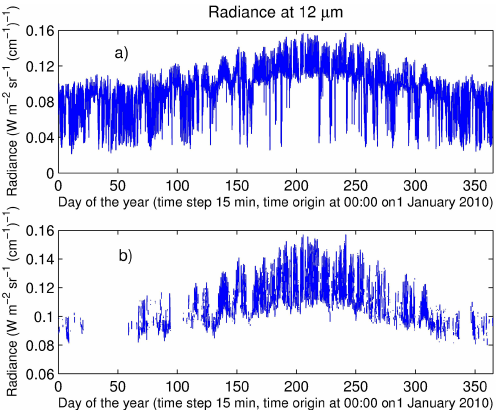
Figure 4. Yearly SEVIRI 12µm channel data record for the valida- tion station of Evora: (a) original radiance data record and (b) after removing cloudy